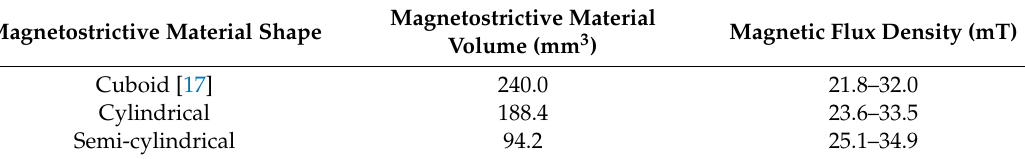
Table 1. Summary of sensors with di ff erent structures.